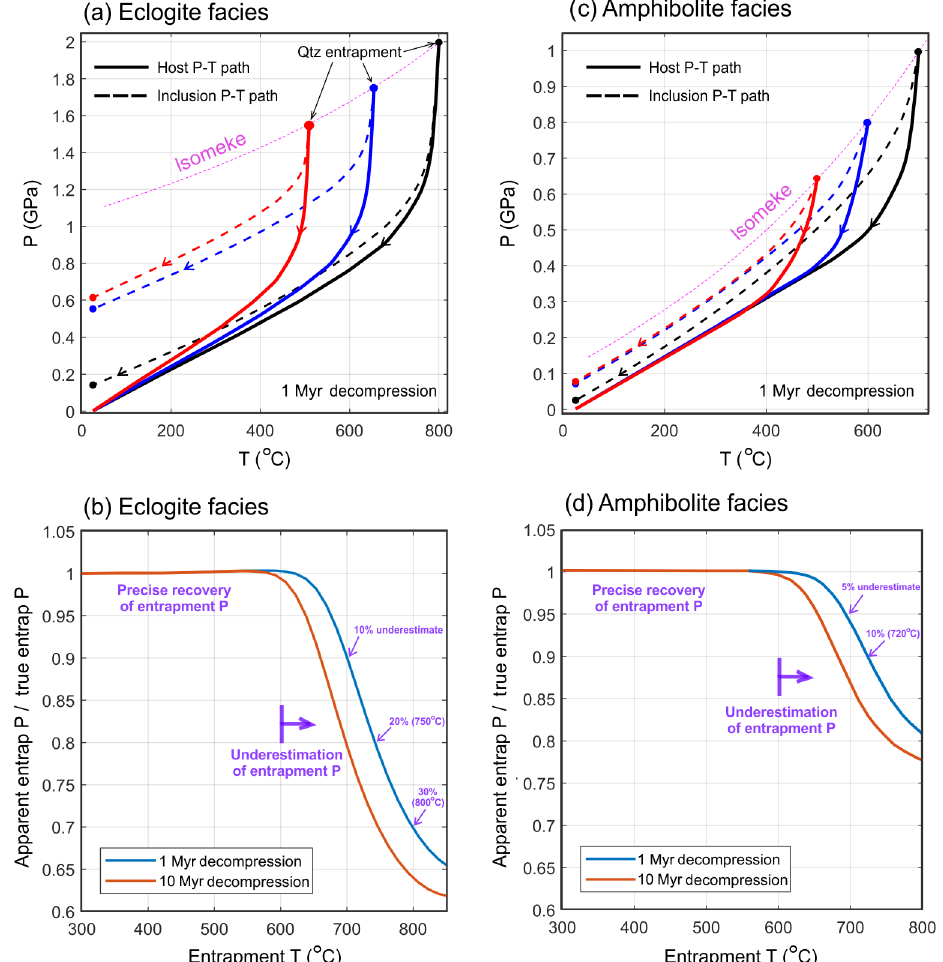
Figure 4. (a) Synthetic retrograde P – T paths from eclogite-facies metamorphic conditions. The quartz inclusions are entrapped within almandine at different peak P – T conditions along the same isomeke; thus a purely-elastic model would predict the same value for the residual inclusion P . Due to viscous relaxation, the residual P is lower than the pressure predicted by an elastic model. In (b) , the apparent entrapment P is calculated based on the relaxed residual inclusion pressure given different entrapment T along the elastic isomeke that is given in (a) . Pressure relaxation is manifested by lower values of apparent entrapment P and it becomes more significant if the host experiences high temperatures with time. Panels (c) and (d) are the same plots for amphibolite-facies entrapment conditions. The amount of viscous relaxation is less compared to eclogite facies due to the lower magnitude of inclusion overpressure and the stress-dependent viscosity of garnet host. Pure almandine garnet is used as host, and its flow law is from Wang and Ji